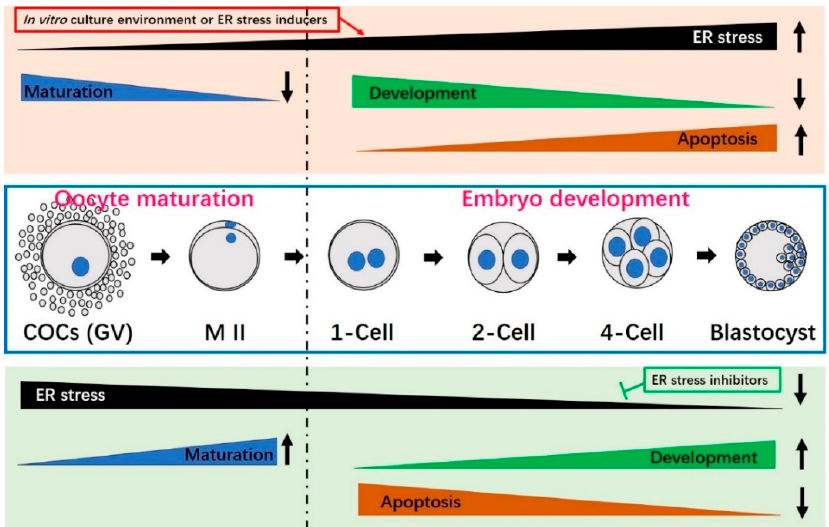
Figure 4. The influences of endoplasmic reticulum (ER) stress on oocyte maturation and preimplantation embryo development. Oocyte maturation and/or embryo culture environments associated with prolonged or severe ER stress (e.g., treatment with the ER stress inducer, TM) can significantly reduce oocyte maturation, decrease embryo developmental potential and increase apoptosis (top box with light pink color). When ER stress is inhibited by an ER stress inhibitor (e.g., TUDCA), maturation and development improve and the apoptotic index decreases (bottom box with light green color). Oocyte maturation is shown to the left of the broken black line, while embryo development is presented on the right. COCs, cumulus oocyte-complexes; GV, germinal vesicle; M II, metaphase II.